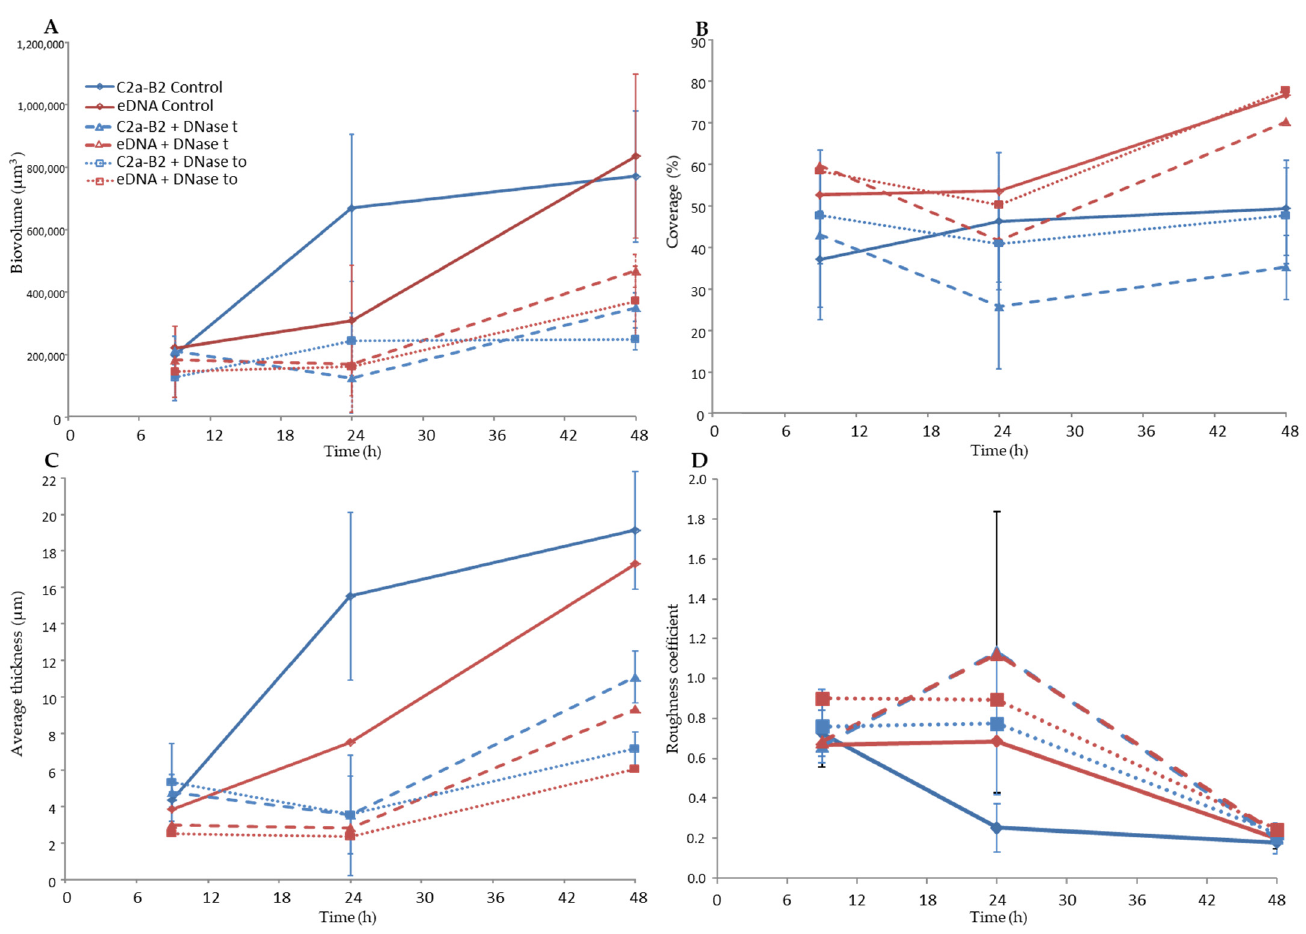
Figure 2. Quantitative structural parameters of the biofilms of S. xylosus C2a-B2 and eDNA stained by TOTO-3 at three sampling times. ( A ) Biovolume, ( B ) Coverage, ( C ) Average thickness and ( D ) roughness coefficient. Biovolume C ( µ m 3 ) represented the overall volume of cells in the observation field. Coverage (%) reflected the efficiency of substratum colonization by bacteria. The average thickness ( µ m) of biofilms was determined from the confocal stack images. Roughness coefficient provided a measure of variations in biofilm thickness and was an indicator of the superficial biofilm interface heterogeneity. Three independent experiments were performed per sampling time. C2a-B2 control (continuous blue curve) and eDNA control (continuous red curve): no treatment; C2a-B2 + DNase t (dashed blue curve) and eDNA + DNase t (dashed red curve): DNase treatment at the end of each incubation time; C2a-B2 + DNase to (dotted blue curve) and eDNA + DNase to (dotted red curve): after incubation in the presence of DNase from the start.